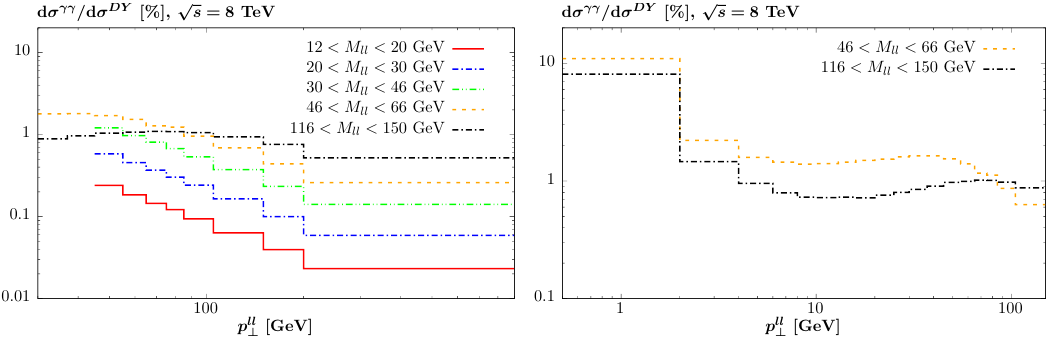
Figure 6 . Percentage contribution from photon-initiated production to the lepton pair p ? distri- bution, within the ATLAS [29] o(cid:11)-peak event selection, at 8 TeV. The photon-initiated cross section is calculated using (2.1) directly, while the QCD predictions in the left (right) plots correspond to NNLO (NNLO+NNLL) QCD